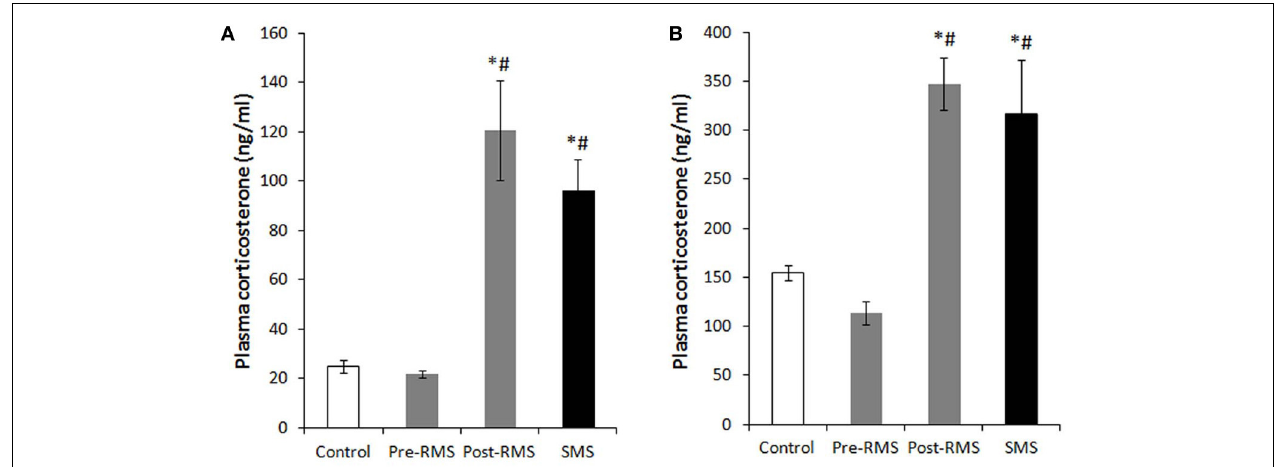
FIGURE 1 | Plasma CORT levels of repeated maternal separation (RMS) and single-time maternal separation (SMS) mice on PND14 and PND21 (Horii-Hayashi et al., 2013). The graphs show plasma CORT concentrations of PND14 (A) and PND21 (B) ( n = 5–9